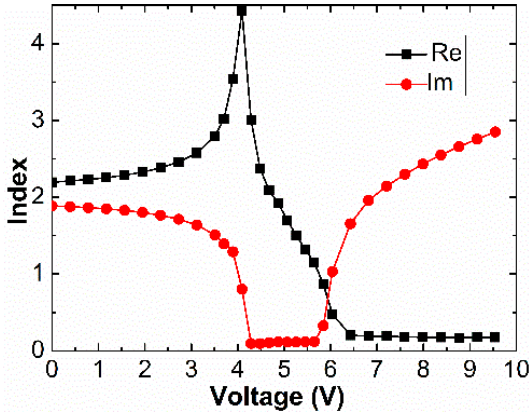
Figure 3. Relative index of graphene as a function of voltage.